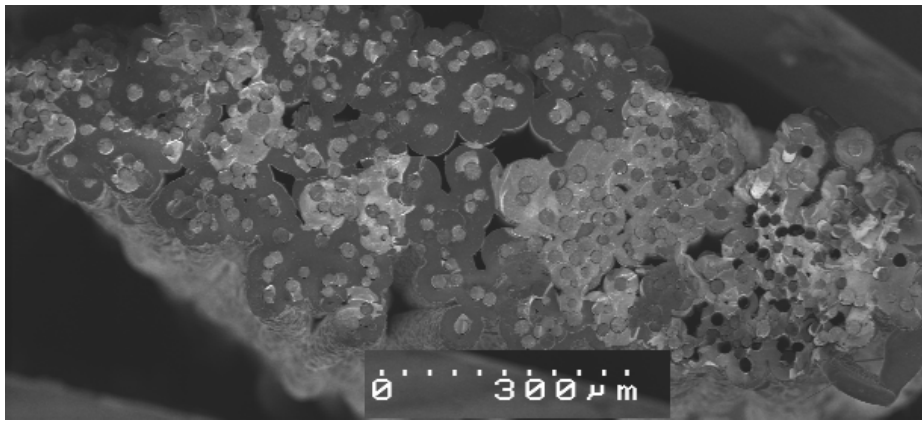
Figure 14. Minicomposite fractured surface after fatigue at 1200 °C, 525 MPa for 16